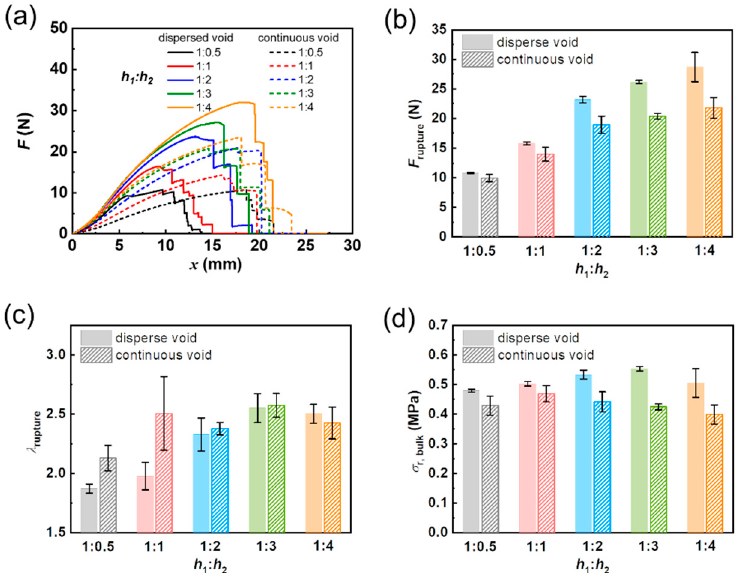
Figure 3. Effect of spacing ratios h 1 : h 2 and dispersed/continuous cuts on the mechanical behaviors of DN hydrogel samples in fracture experiments. ( a ) Summarized force ( F )–displacement ( x ) curves of DN hydrogels. ( b ) Rupture force ( F rupture ), ( c ) critical stretch ratio at rupture point ( λ rupture ), and ( d ) critical bulk stress at rupture point ( σ r,bulk ) for DN hydrogel samples containing dispersed cuts (D-cut gels) and continuous cuts (C-cut gels) at different spacing ratios h 1 : h 2 (1:0.5, 1:1, 1:2, 1:3, and 1:4). The critical stretch ratio at the rupture point λ rupture is further analyzed in Figure